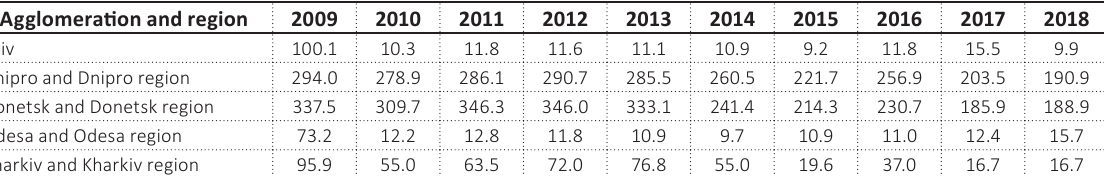
Table 2. Considering the environmental factor* by regions with the largest agglomerations in Ukraine, kg/person Agglomeration and region